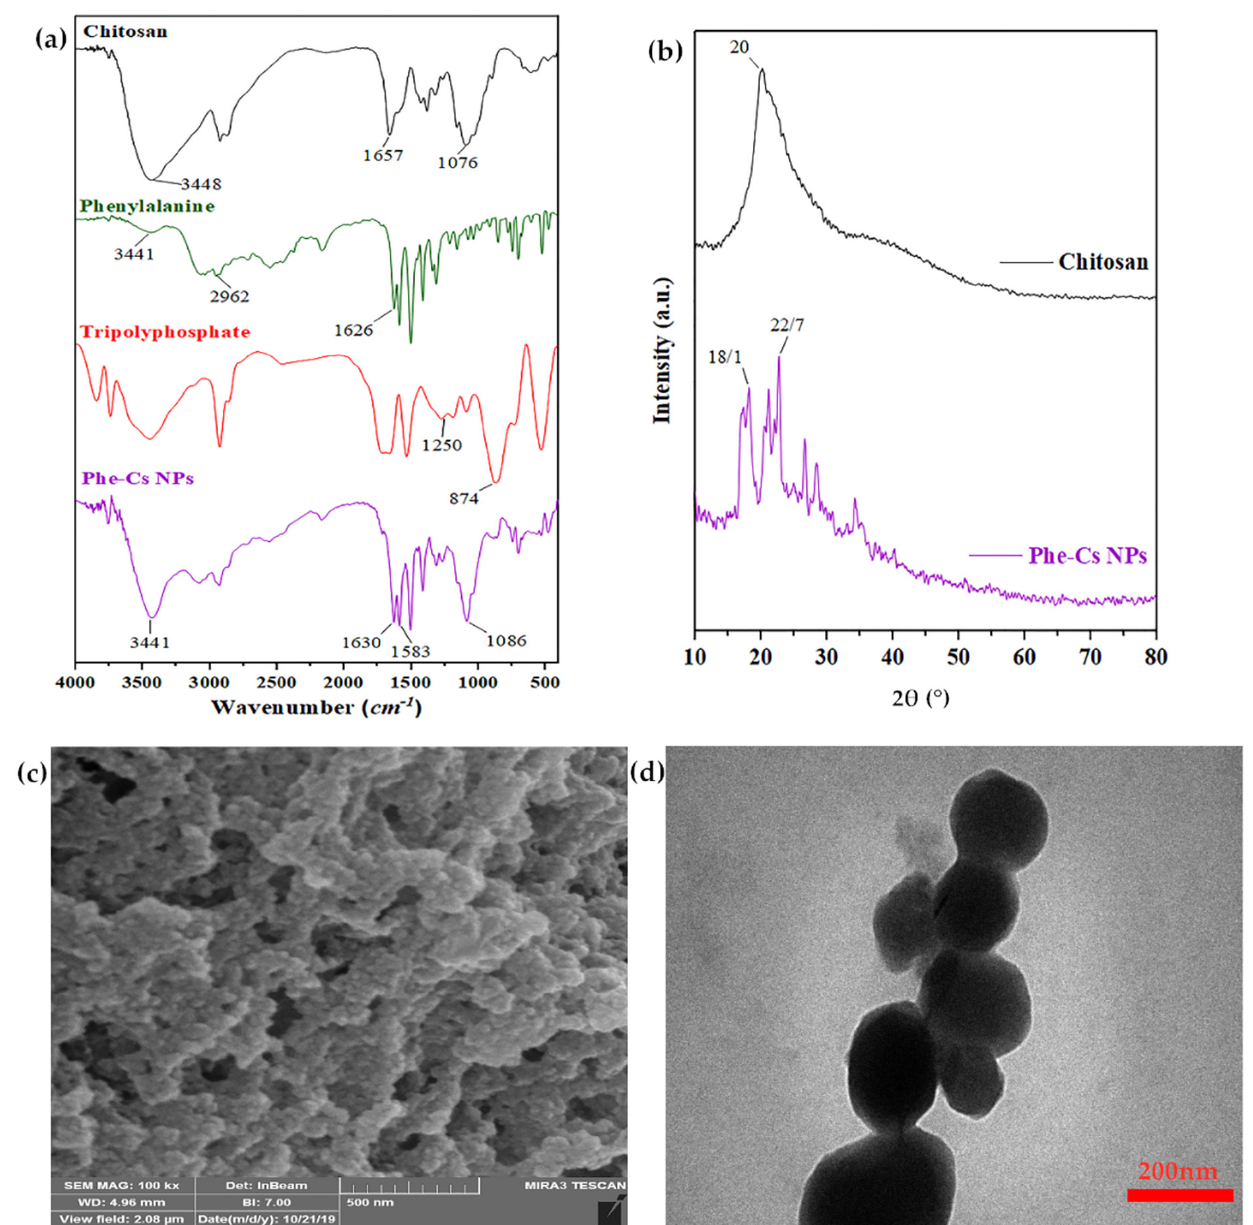
Figure 1. FT-IR ( a ), XRD ( b ) SEM ( c ), and TEM ( d ) analysis of starting materials and chitosan-phenylalanine nanoparticles (Cs-Phe NPs).